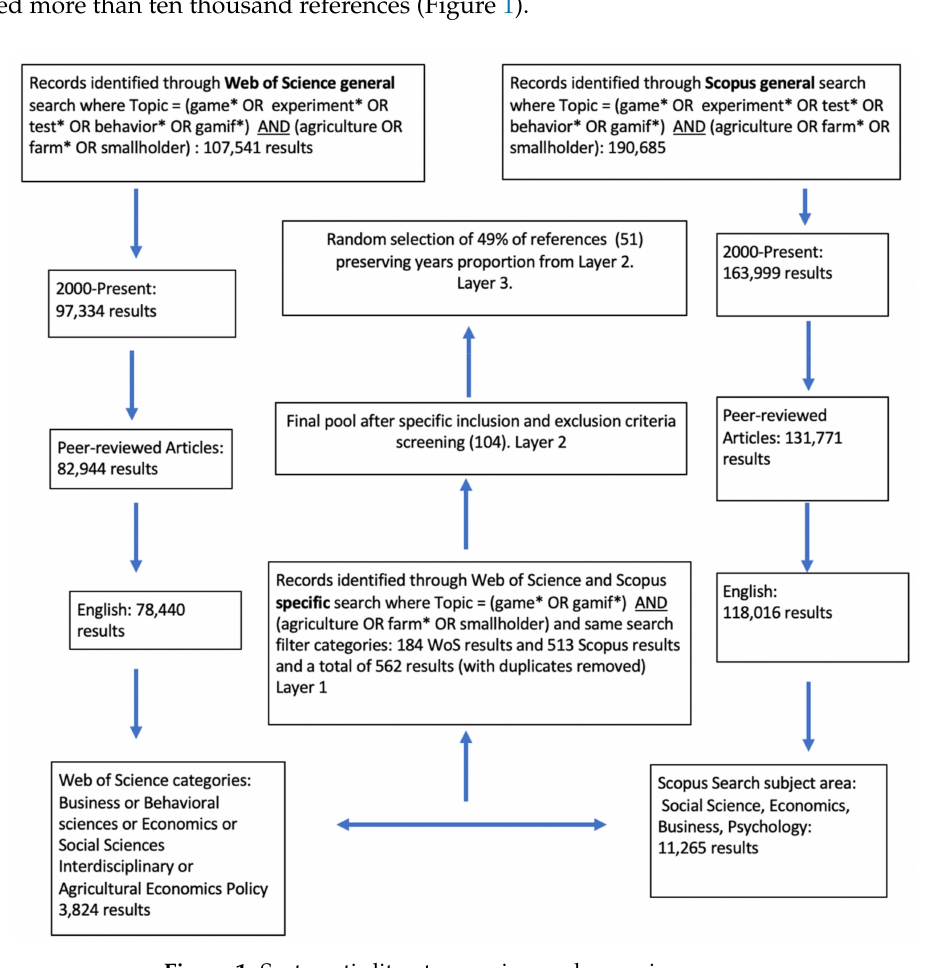
Figure 1. Systematic literature review and screening